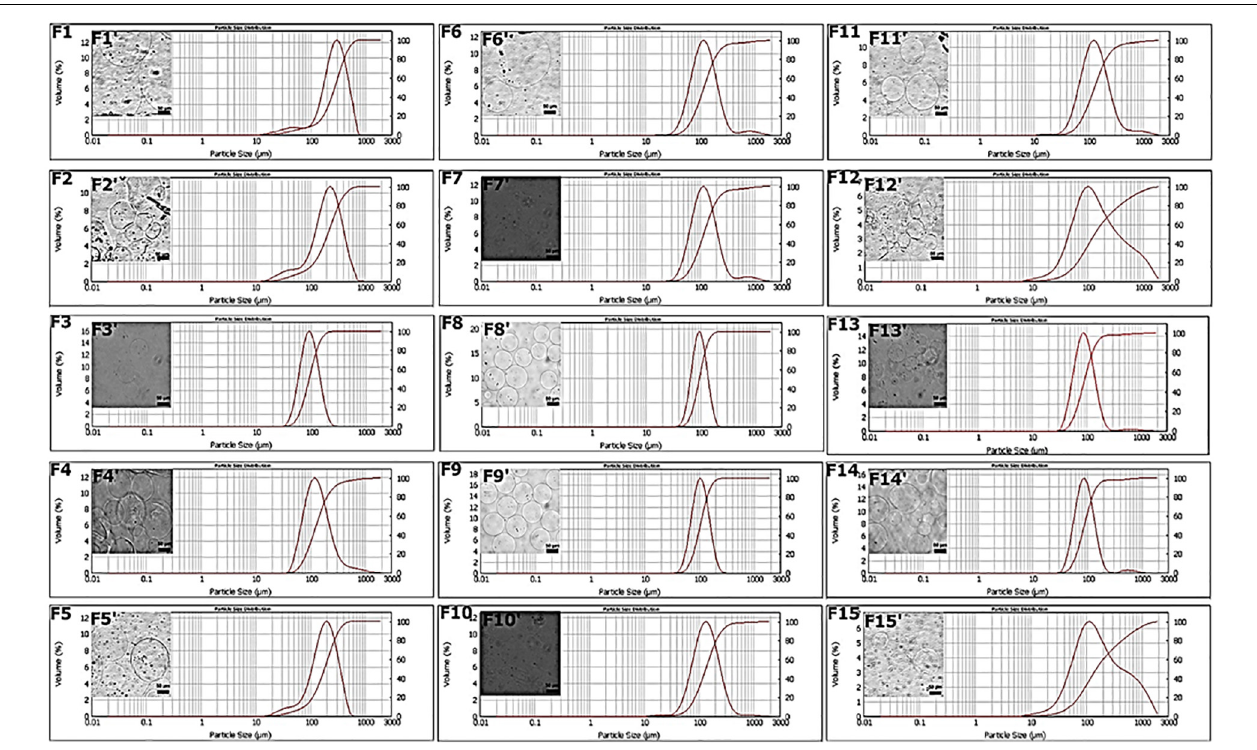
FIGURE 2 | Chemical–physical (F1–F2) and morphological characterization (F1 (cid:48) –F2 (cid:48) ) of